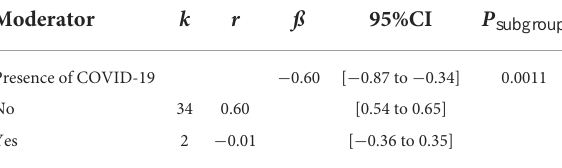
TABLE 3 Moderating effect of COVID-19 and subgroup